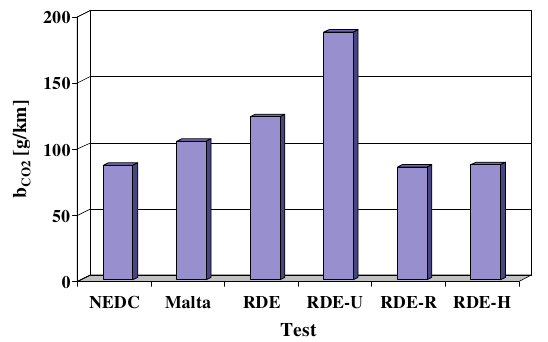
Fig. 11. Mean carbon dioxide road emissions – b CO2 in each of the test cycles